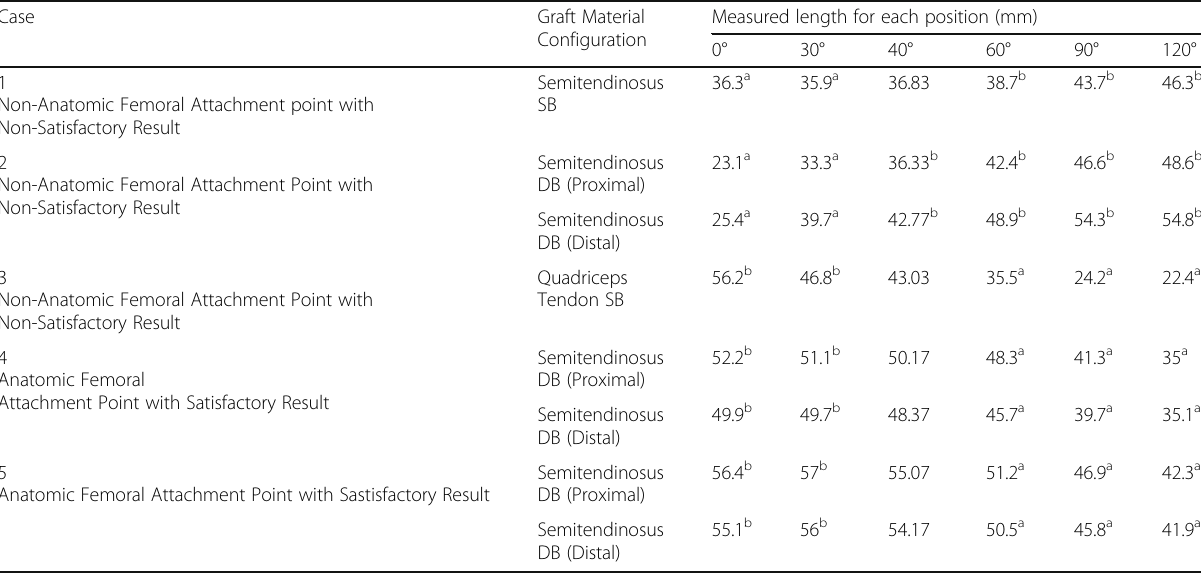
Table 5 Patient-specific data for the model validation